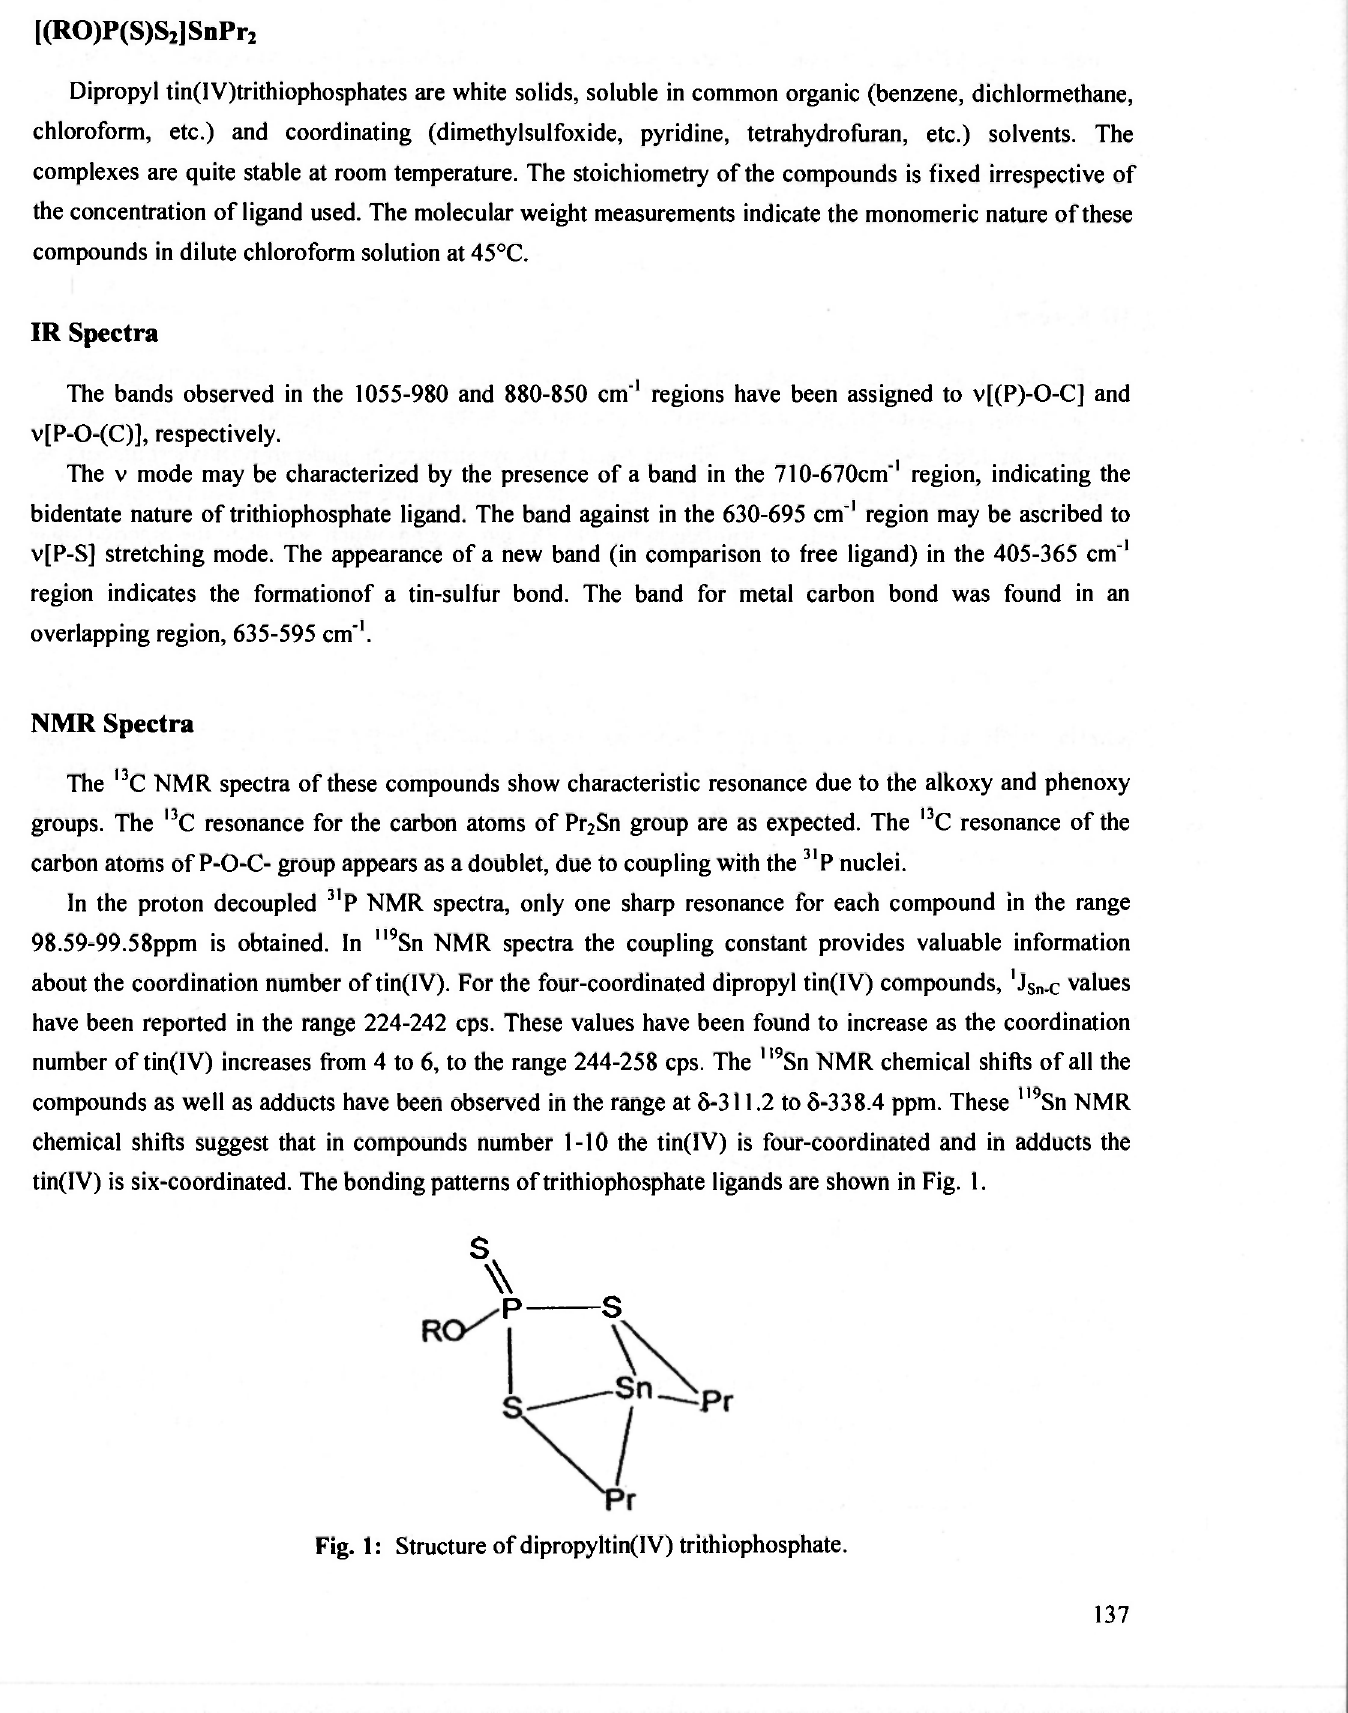
Fig. 1 : Structure of dipropyltin(I V)